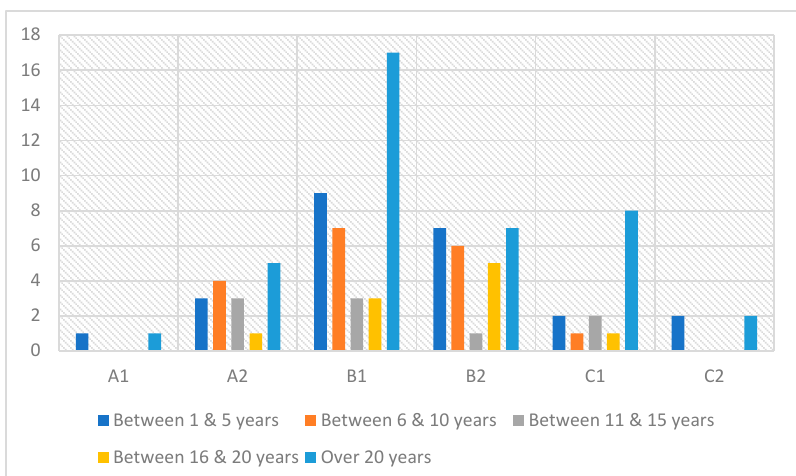
Figure 5. Level of Digital Competence by Teaching Experience.